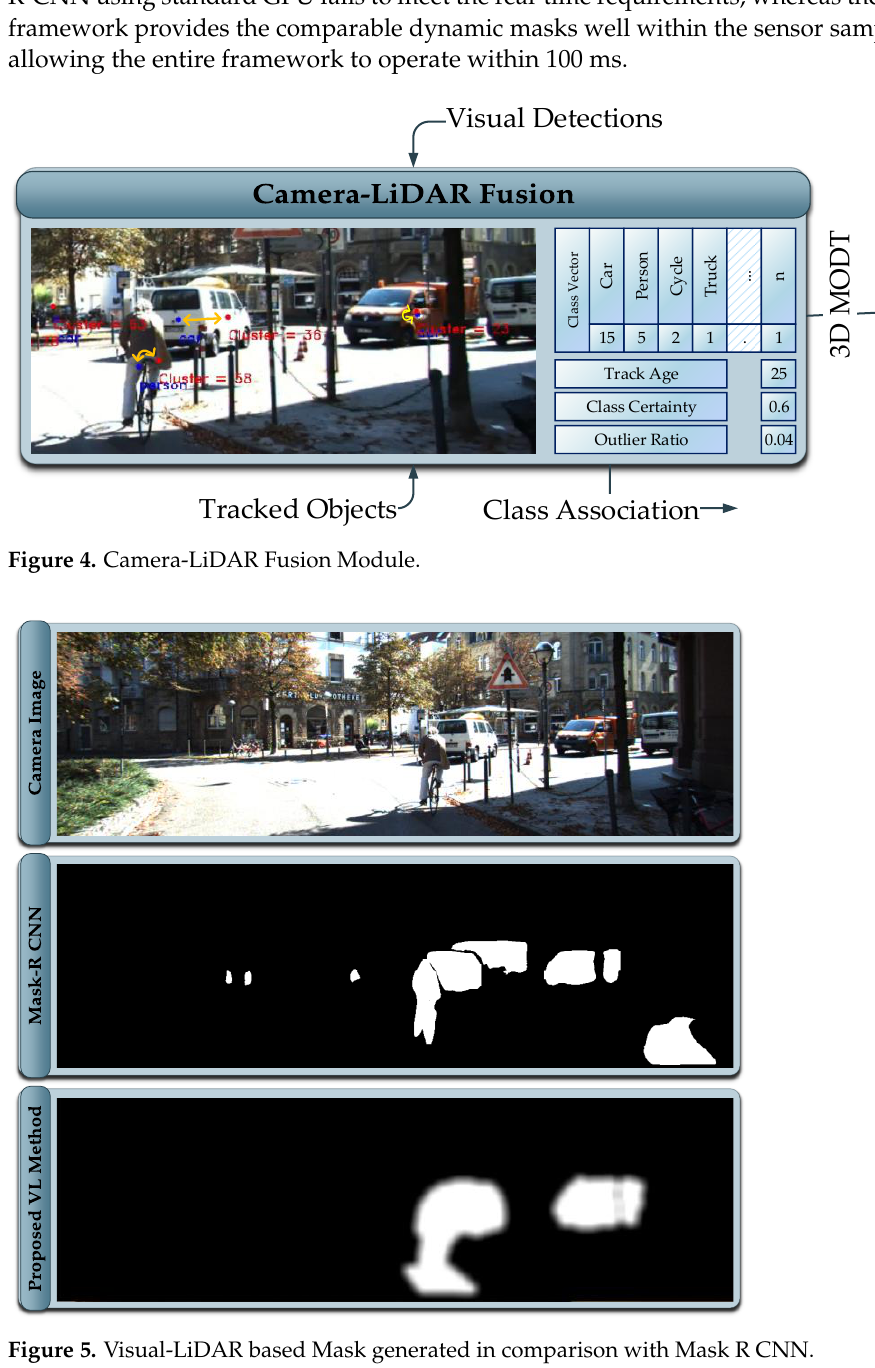
Figure 5. Visual-LiDAR based Mask generated in comparison with Mask R CNN.